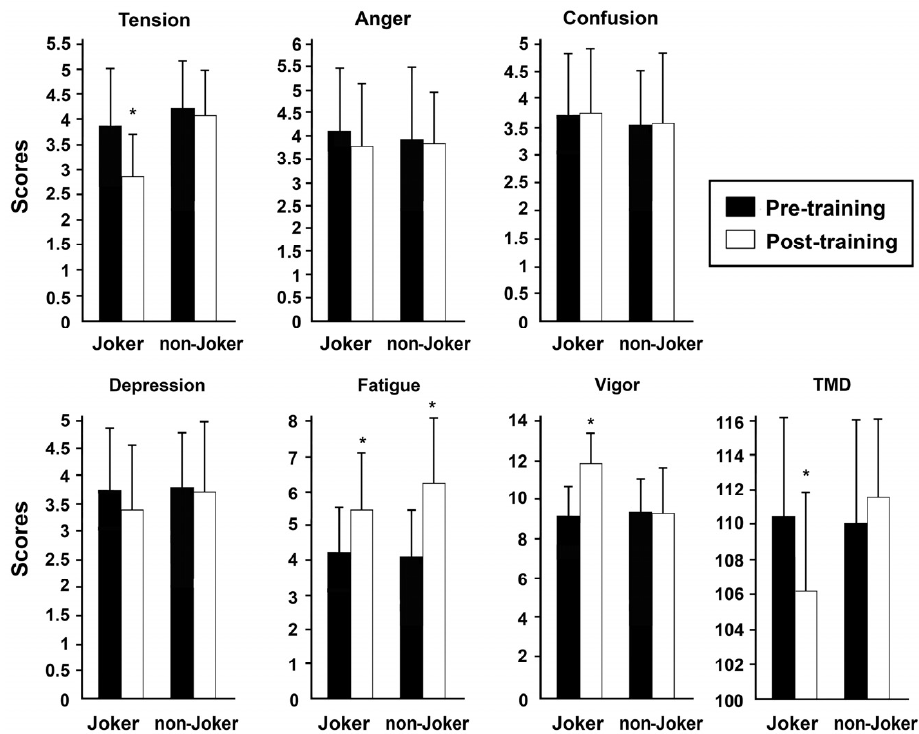
Figure 2. POMS scores measured before and after small-sided games (SSG) with or without joker. * p < 0.001, by ANOVA .